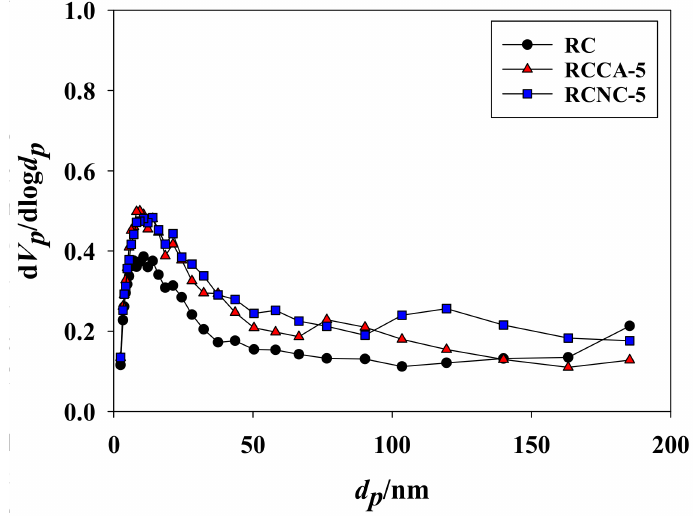
Figure 9. The pore size distribution of composite aerogel beads after adsorption of Cd 2+